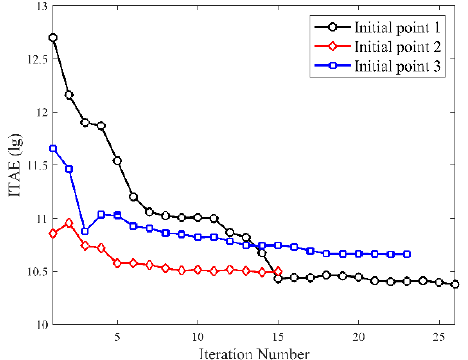
Figure 16. Trajectories of iterative at different initial points.